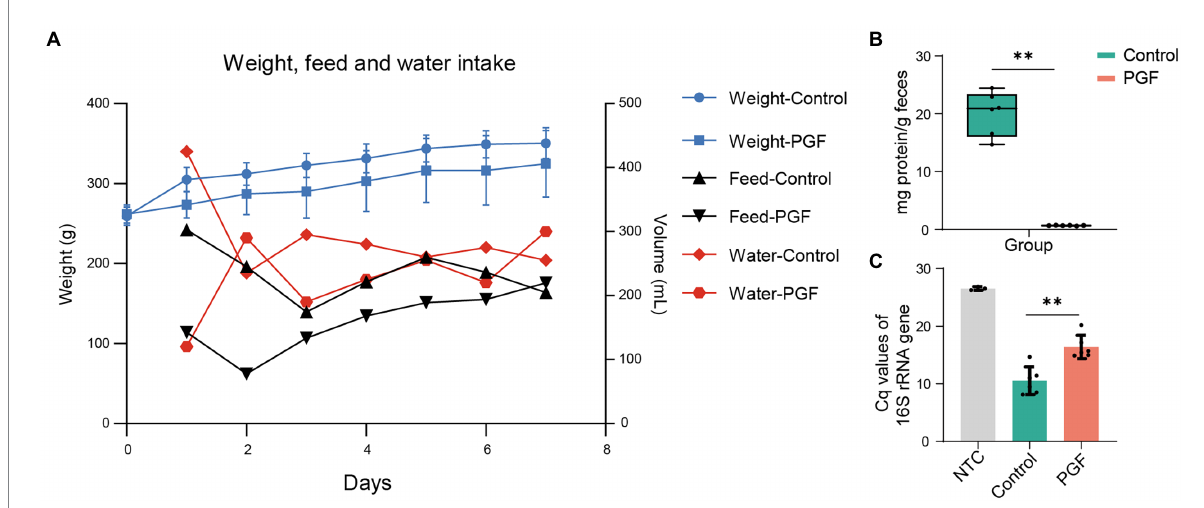
FIGURE 2 (A) Weight, feed and water intake in the control and PGF groups during antibiotics-treatment. The body weight was shown as mean ± SD ( n = 6). Data of water and feed intake was shown as the sum of consumption in the respective group. (B) Total enzyme content in feces ( n = 6); (C) Relative abundance of total DNA of two groups evaluating by the 16S rRNA gene Cq values ( n = 6). Data of samples was shown as black dots, and the error bars denoted SD, * p < 0.05 and ** p <